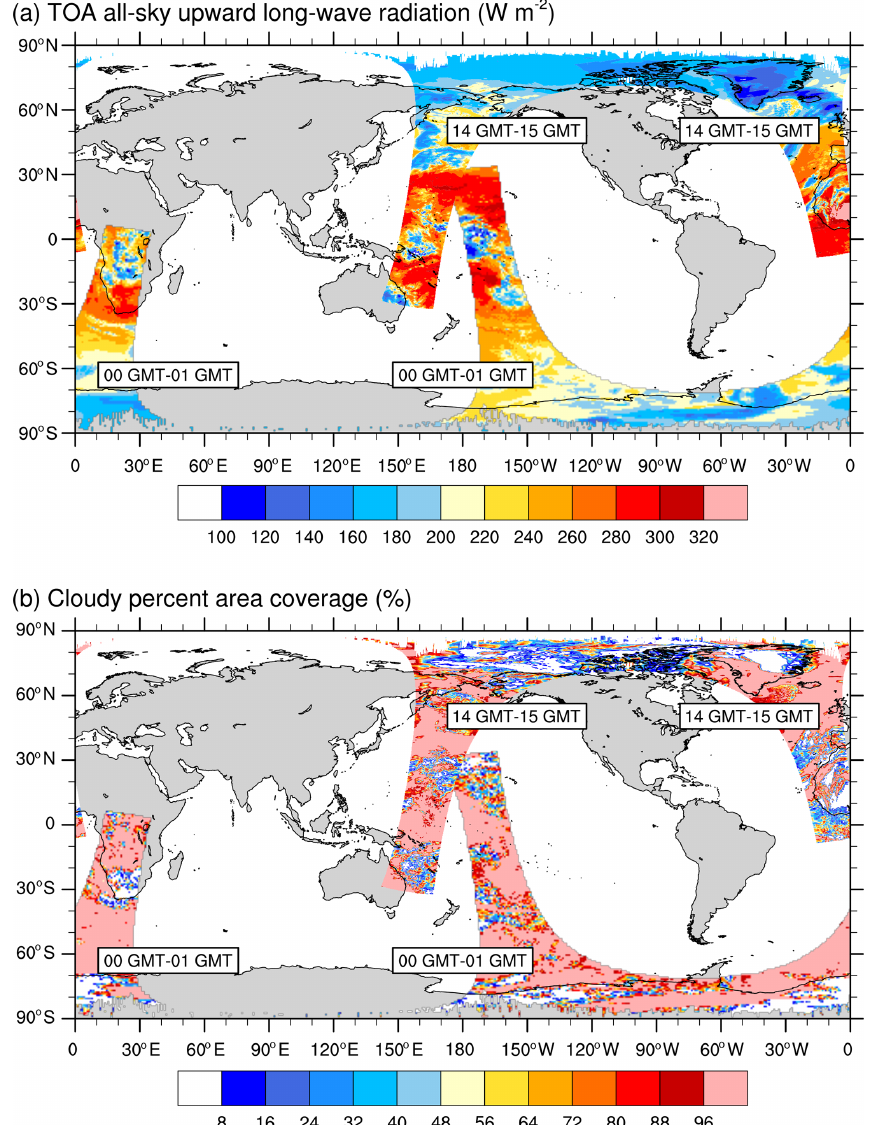
Figure 3. Orbital paths of the Aqua satellite between 00:00 and 01:00 and 14:00 and 15:00GMT after binning the SSF data onto a 0 . 2 ◦ × 0 . 2 ◦ rectangular grid for (a) the TOA all-sky upward longwave radiation and (b) the cloudy percent area coverage for 1 December